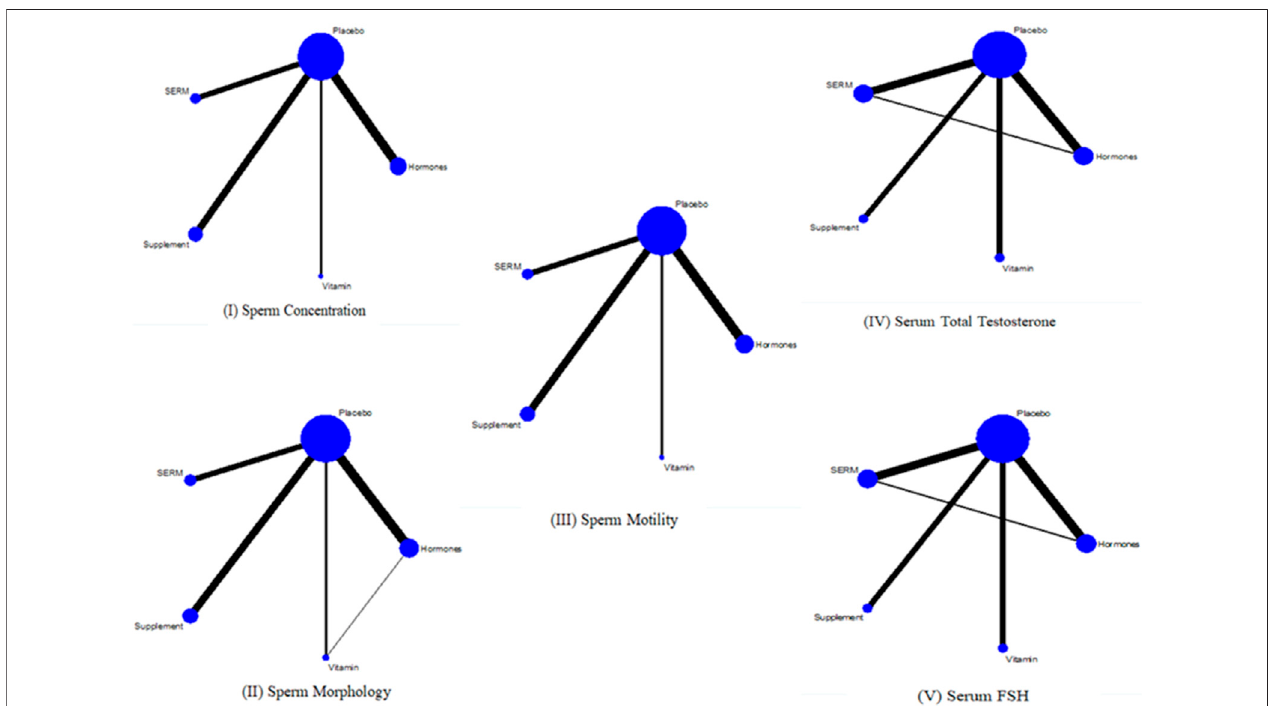
TABLE 3 | Network meta-analysis for impact various pharmacological group interventions on primary and secondary clinical outcomes of male infertility. Outcome parameter Intervention vs.